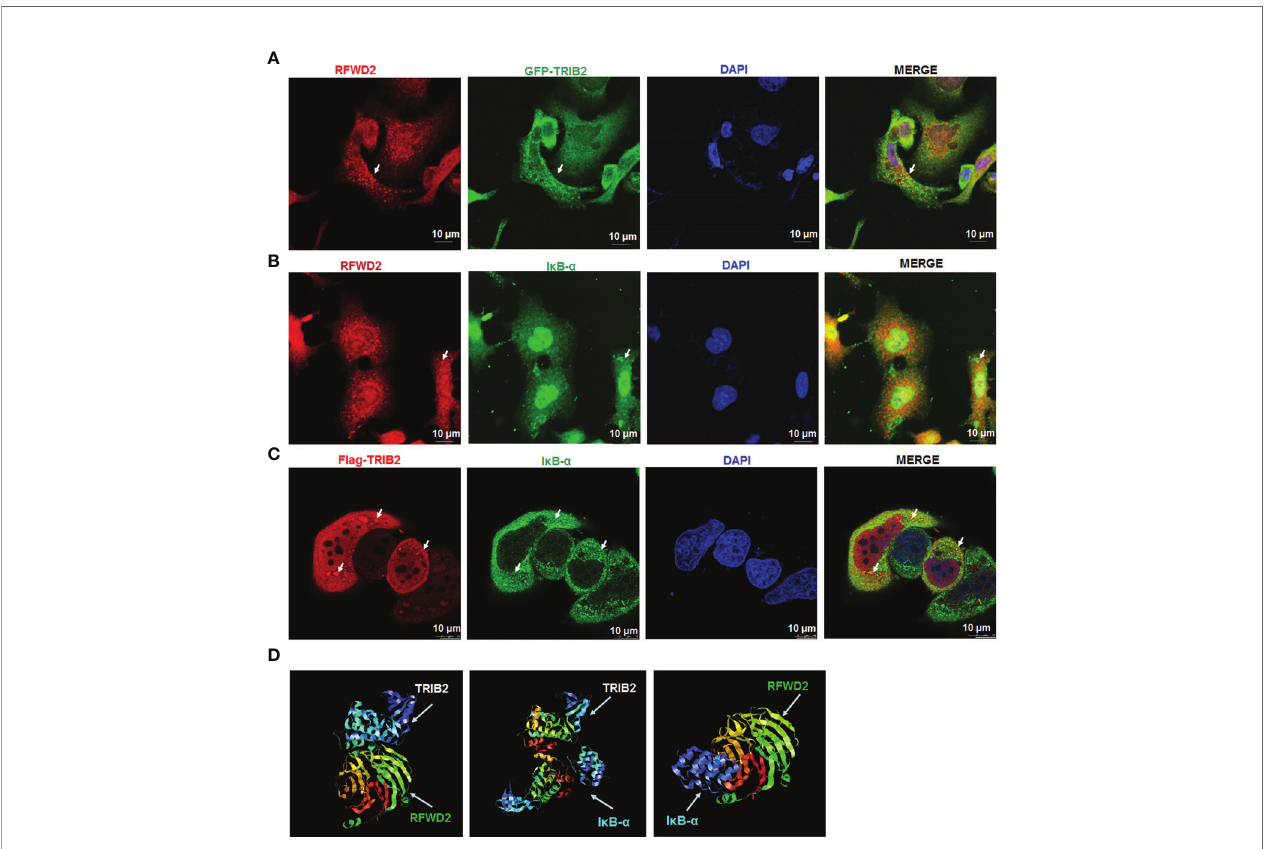
FIGURE 4 | Colocation analysis between TRIB2, RFWD2, and I k B- a . (A) Colocalization of RFWD2 (red) and GFP-TRIB2 (green) in A549 cells, observed via confocal microscopy. Immunostaining was performed with primary RFWD2 antibody after A549 cells were treated with GFP-TRIB2. Scale bar = 10 µm. (B) Immunostaining of A549 cells with antibodies against RFWD2 (red) and I k B- a (green). Scale bar = 10 µm. (C) A549 cells transfected with Flag-TRIB2 and subjected to immunostaining with antibodies against I k B- a (green) and TRIB2 (red). Scale bar = 10 µm. (D) Interactions between TRIB2, I k B- a , and RFWD2 analyzed via the PRODIGY